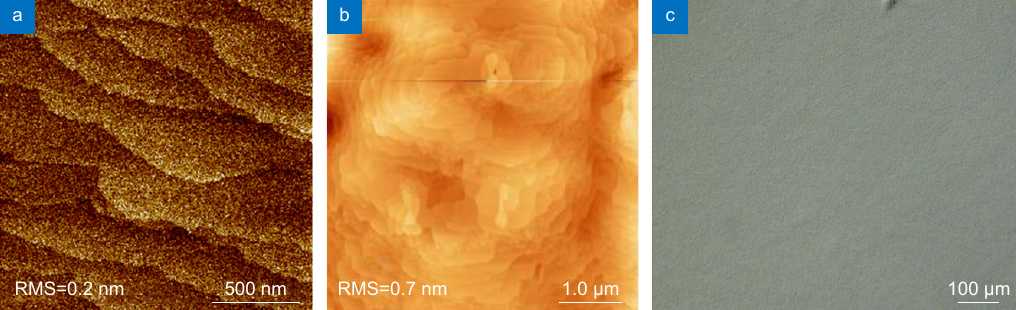
Fig. 4 | AFM images and Nomarski microscope image of the epitaxial regrowth on bonded substrate from HPE, III-V Lab and Sophia University. Figure repoduced with permisson from: (a) ref. 29 ,under a Creative Commons Attribution 4.0 International License; (b) ref. 32 , (c) ref. 26 ,